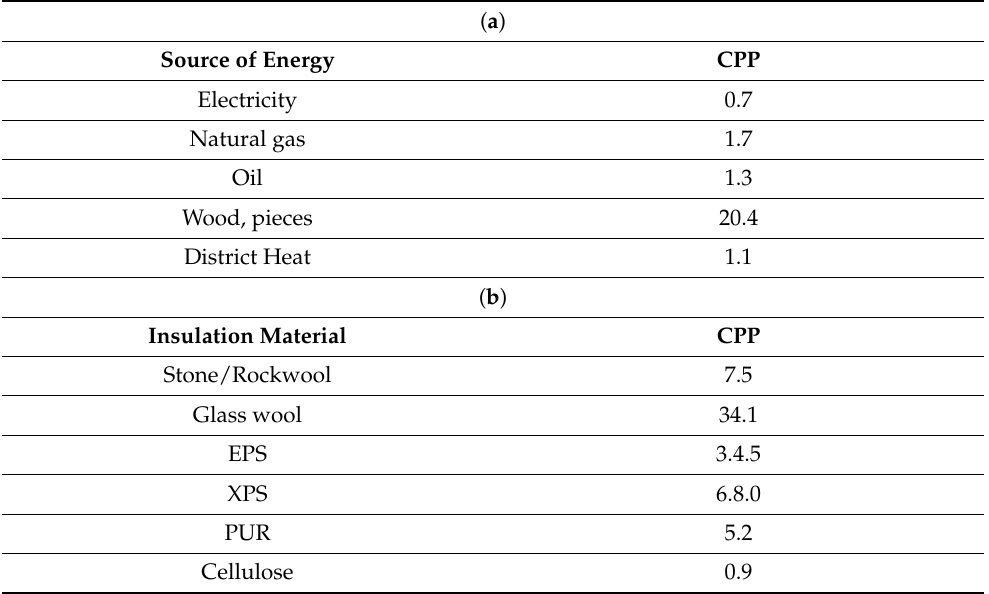
Table 11. ( a ): Average CPP values for different energy sources. ( b ): Average CPP values for various insulation